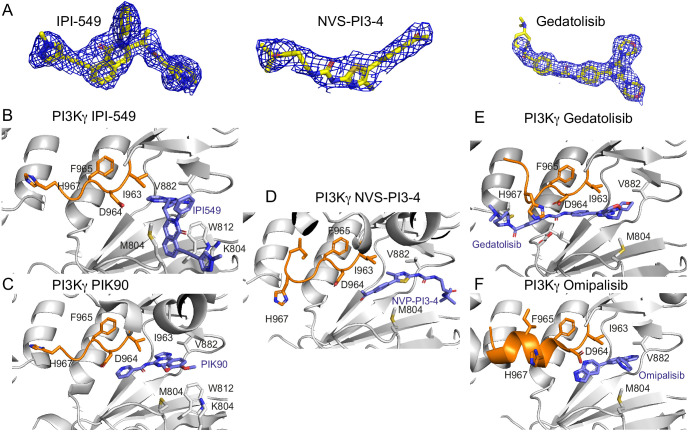
Binding of IPI-549, NVS-PI3-4, and Gedatolisib lead to different conformations of the activation loop of p110γ.(A) The electron density from a feature enhanced map (Afonine et al., 2015) around IPI-549, NVS-PI3-4, and Gedatolisib contoured at one sigma. (B–F) Conformations of the activation loop of p110γ in the presence of annotated inhibitors. Structures of PIK90, and Omipalisib bound to p110γ were from PDB: 2CHX (Knight et al., 2006) and 3l54 (Knight et al., 2010), respectively.